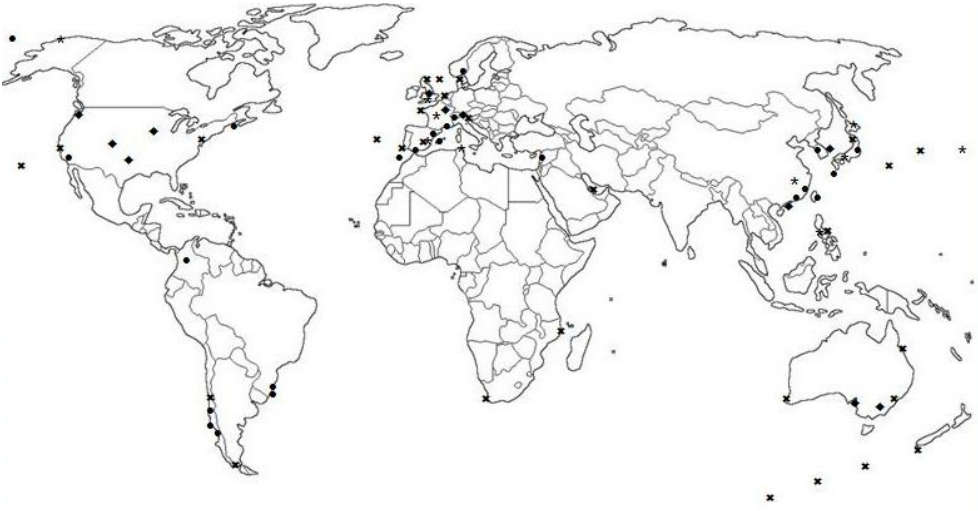
Figure 1. Graphic overview of the sampling locations for waters, sediments, and/or organisms cited in the References. ● = UV fi lters (References [5–31]); * = parabens (References [32–42]); ♦ = triclosan